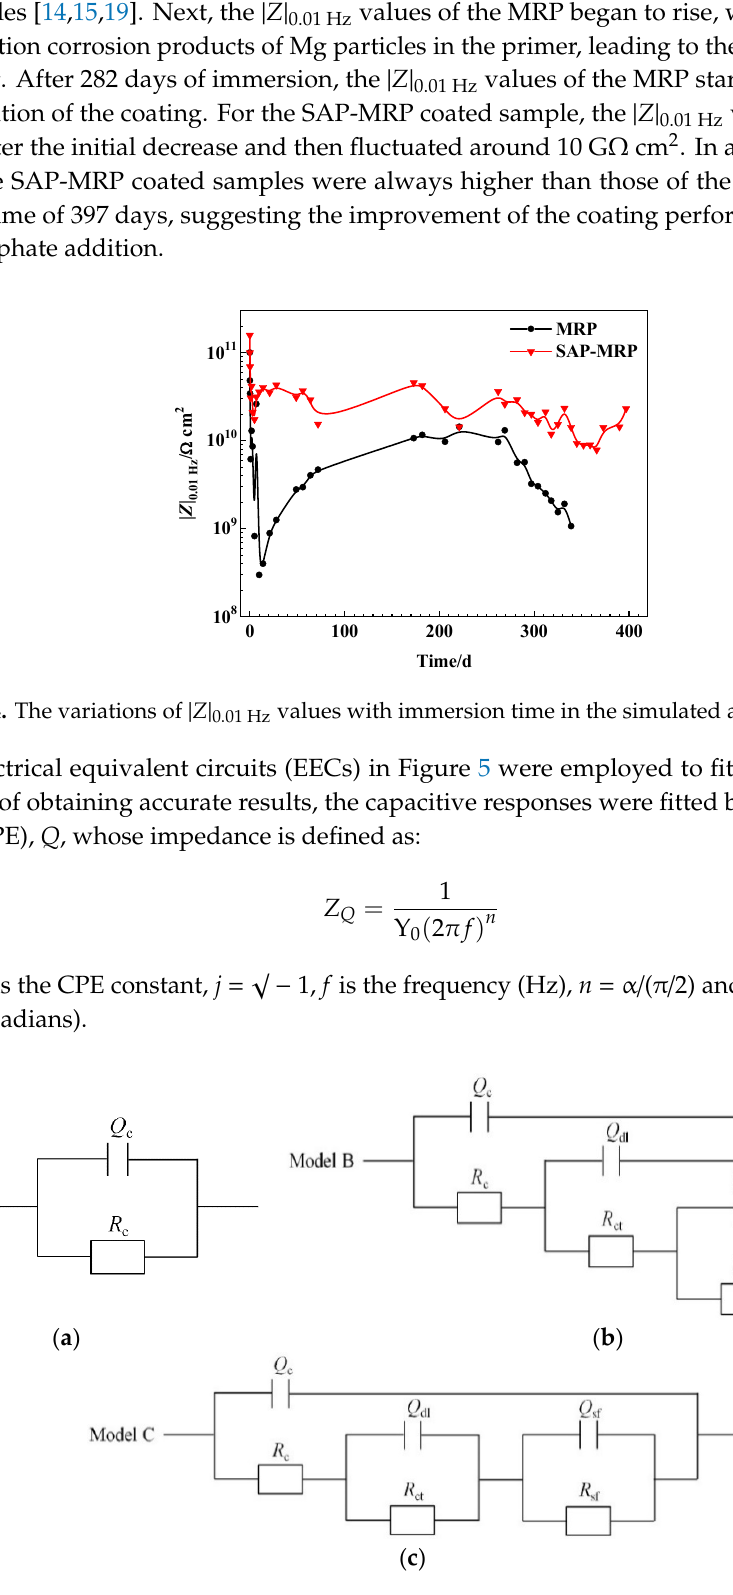
Figure 5. Electrical equivalent circuits (EECs) used to fit the EIS spectra: ( a ) initial stage, ( b ) stable stage and ( c ) late stage.